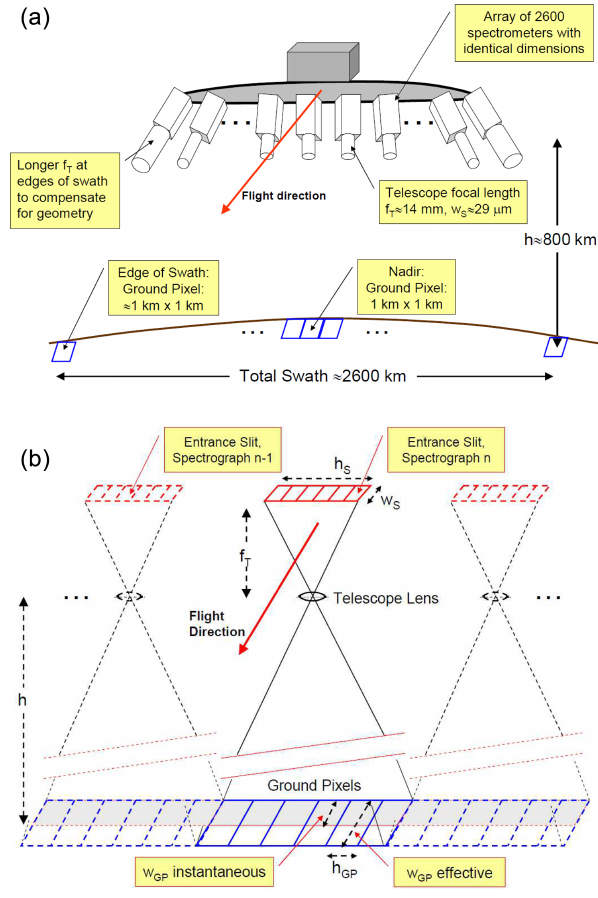
Figure 7. (a) Possible arrangement of an array of spectro- graph + telescope combinations for satellite application (this exam- ple depicts the “scaled 2” arrangement; see Table 2). In principle, there is one spectrograph + telescope for a viewing direction (i.e. ground pixel; see Table 2). (In the case of the “scaled 2” arrange- ment, two spectrographs observe the same ground pixel to improve the S/N ratio.) Longer focal lengths f T of the telescope observing ground pixels near the edge of the swath could be chosen to com- pensate for their larger size. For simplicity, a linear arrangement of the spectrographs along a line is shown; in practice an arrangement in a 2-D array would of course be much more compact. (b) Rela- tionship between the spectrograph entrance slit, instantaneous field of view, and the pixel dimensions. This example depicts a section of the “scaled 1” arrangement, where each spectrograph observes 6 ground pixels; see Table